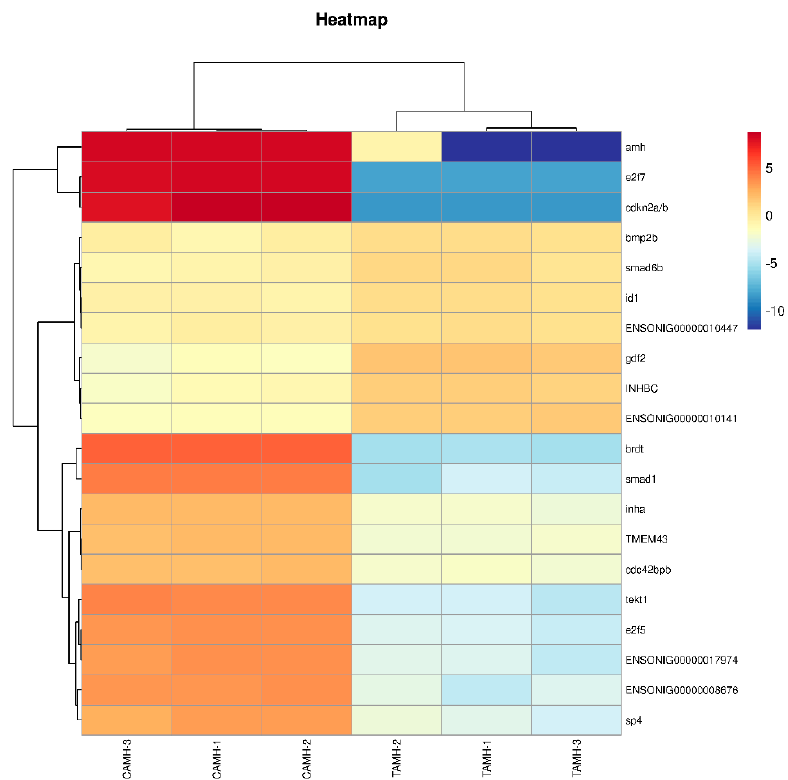
Figure 8. Abnormal TGF-beta signaling pathway caused by knocked-down amh in Nile tilapia. Heat map of the top 20 differentially expressed genes (DEGs) identified in the TGF-beta signaling pathway. DEGs are defined when the |log2 fold change| ≥ 1 and p < 0.05. Colors are scaled per row. Each square indicates the level of gene expression from highest (red) to lowest (blue).